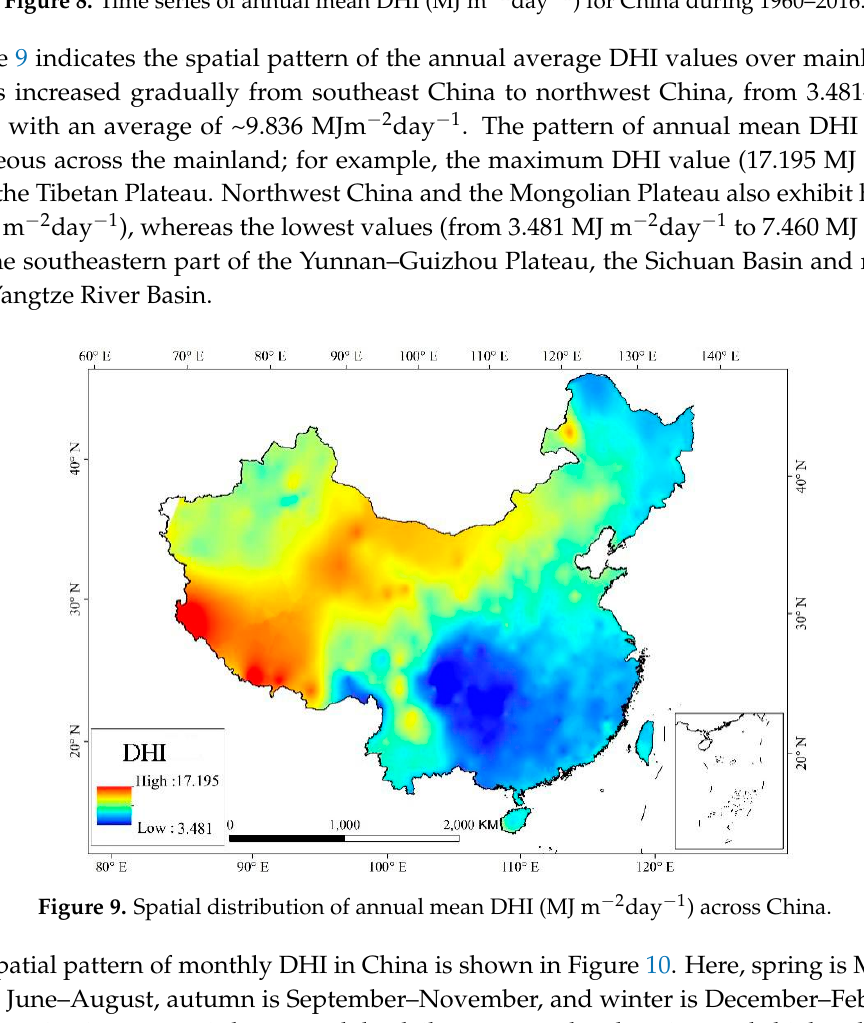
Figure 10. Spatial and temporal changes of DHI (MJ m − 2 day − 1 ) across mainland China Figure 11 shows the monthly average DHI values in different climatic zones. Because cloud cover is the dominant factor affecting surface solar radiation [35], the DHI values are generally higher in semi-arid and arid zones than in humid zones, which have a more frequent cloud occurrence. The ranges of DHI for HIC, HIIC, HID and IID are 8.52–17.94, 8.42–16.54, 6.36–16.54, and 3.90 –18.08 MJ